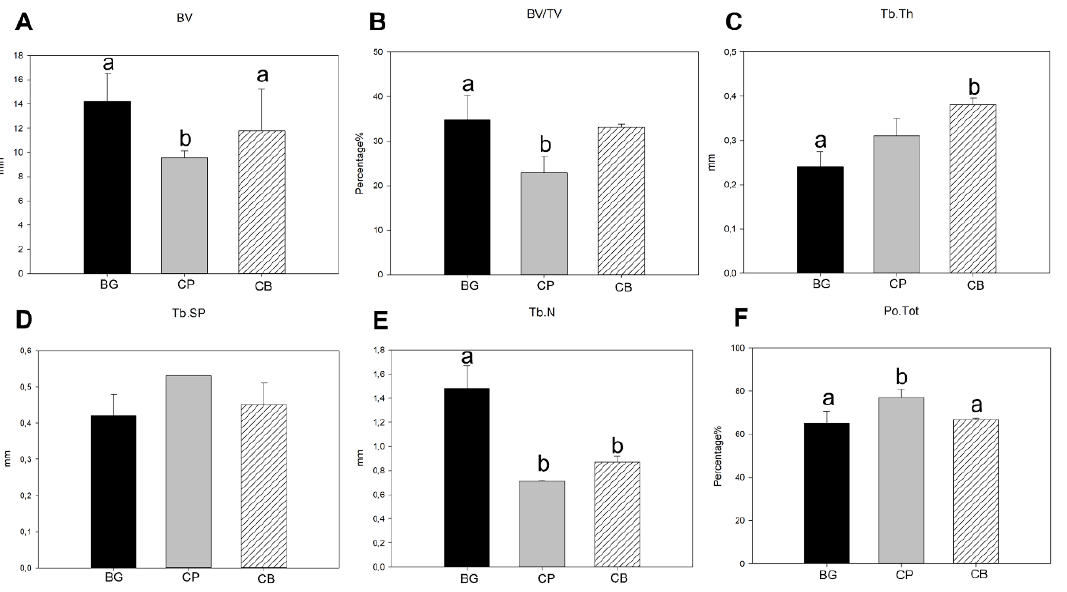
Figure 6. Graphs showing the mean and standard deviation of ( A ) BV, ( B ) BV/TV, ( C ) Tb.th, ( D ) Tb.Sp, ( E ) Tb.n and ( F ) Po. tot in the period of 60 days for groups BG, CP, and CB. Significant statistical differences between groups are represented by different lowercase letters (a, b).